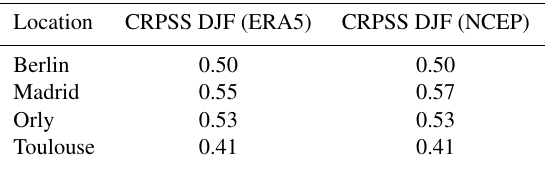
Table 4. Comparison between the values of the CRPSS of SWG computed using different reanalysis datasets for NCEP and ERA5 from 1979 to 2019 for a lead time of T = 5d for winter